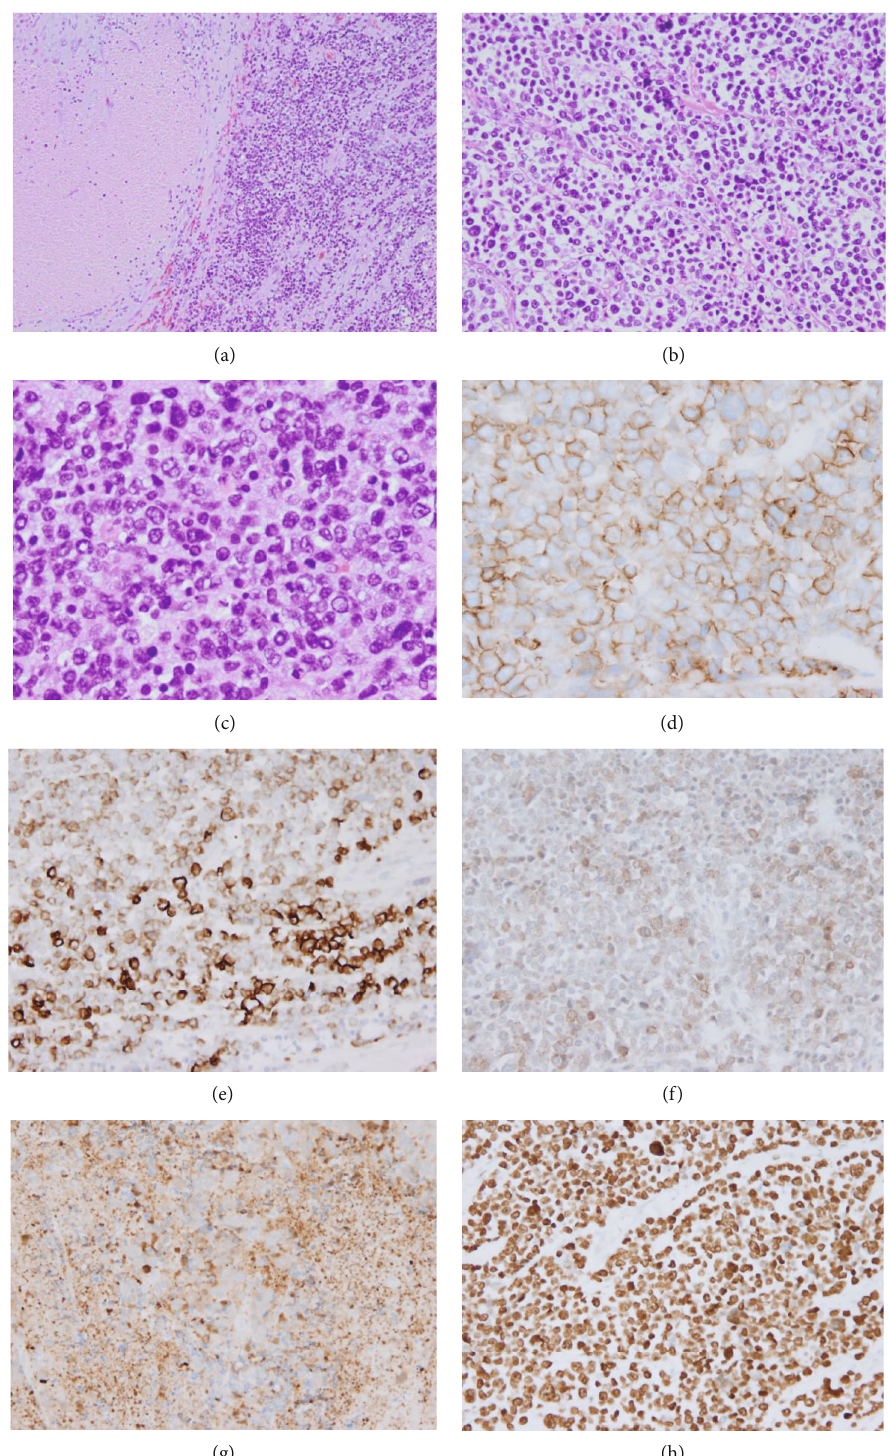
Figure 2: Representative H&E sections of the gallbladder LCNEC and some of the immunostains performed. Very low-power H&E view (20x) of the LCNEC showing necrosis and tumor cells (a), low-power H&E section (40x) showing the trabecular growth pattern (b), and a middle-power view (200x) showing the neuroendocrine features of the LCNEC (c). Sections (d – h) show the CD56, AE1/AE3, c-kit, neuron-speci fi c enolase, and Ki-67 immunostains,